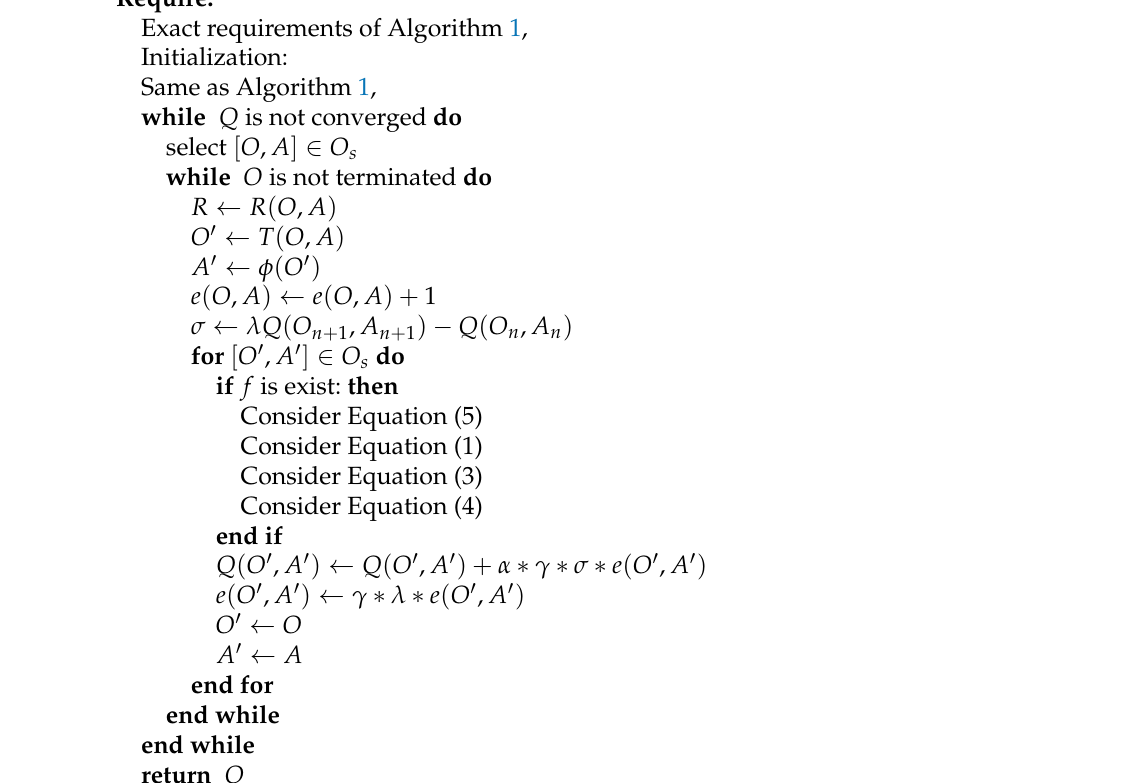
Algorithm 3 Hybrid State-action reward-state-action imitation learning (SARSA/IL)